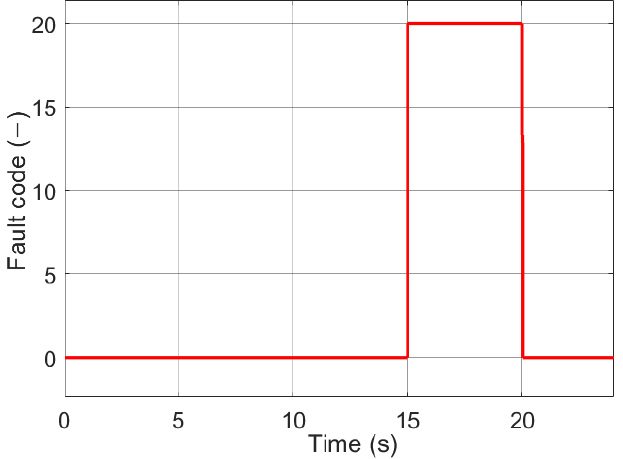
Figure 11. Diagnosis output with a fault code 20, which corresponds to a multi-fault of the left rear wheel speed sensor with a negative offset fault and the yaw rate sensor with a positive offset fault between the 15 to 20